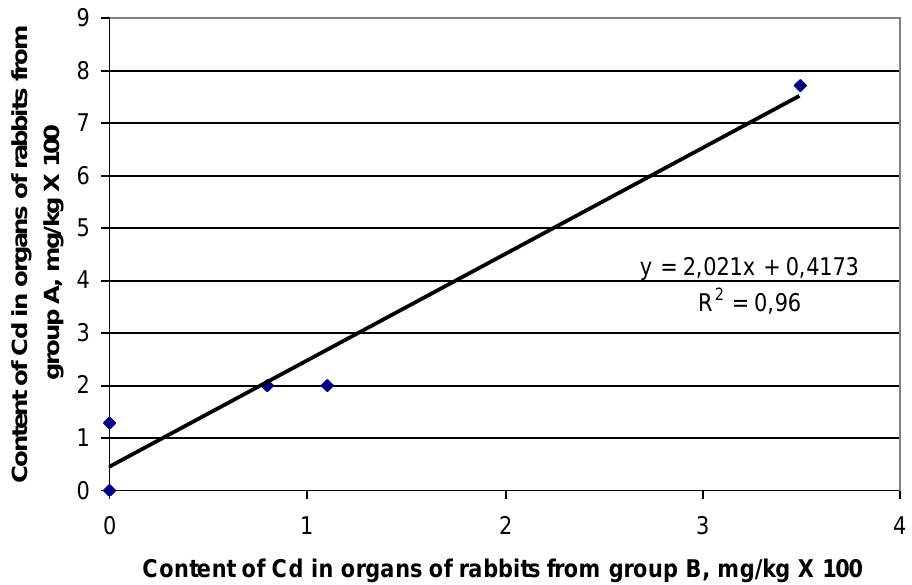
FIGURE 3. Relationship between the content of Cd in the organs of the rabbits from group A and group